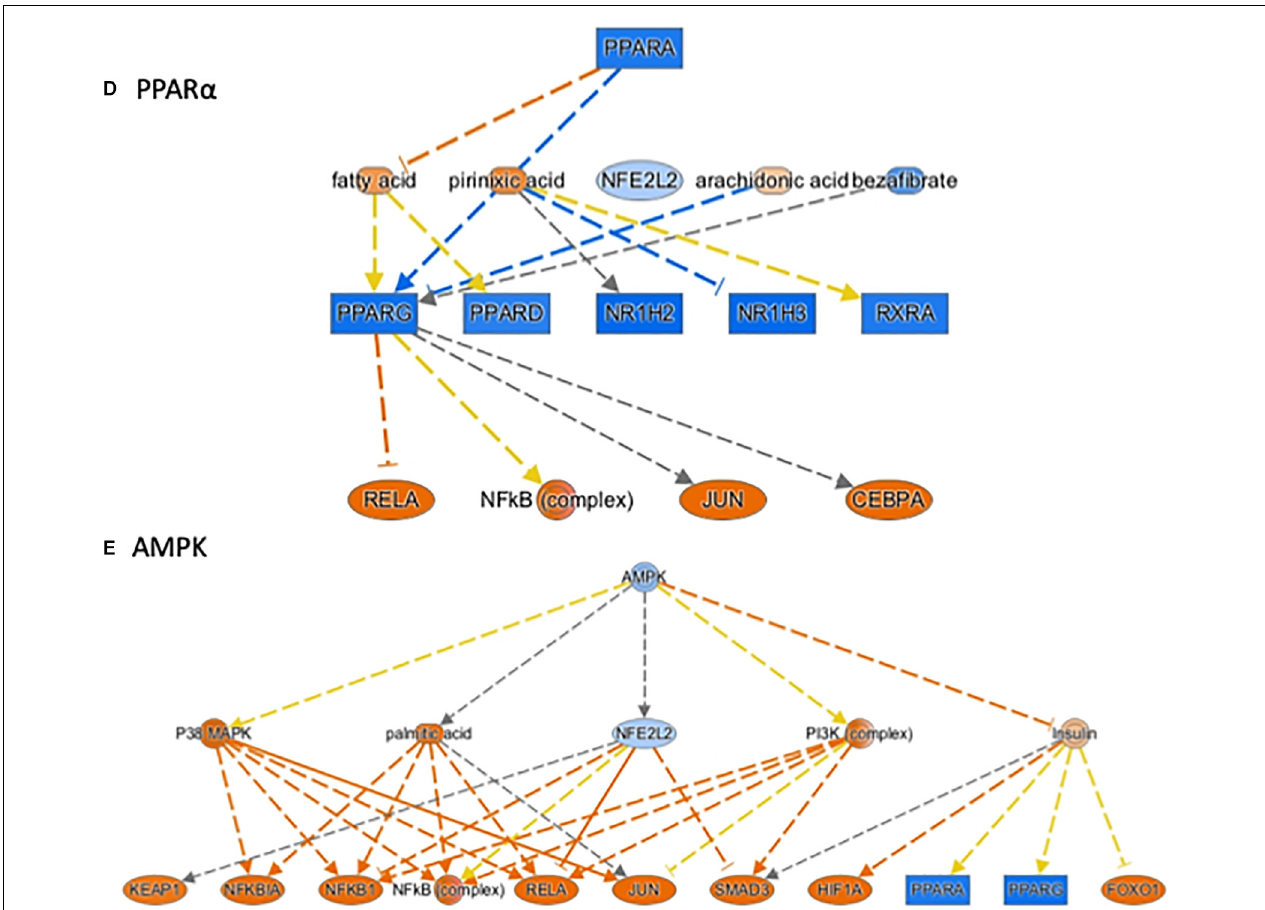
FIGURE 2 | Ingenuity Pathway Analysis R (cid:13) (IPA) annotated mechanistic networks regulated by critical upstream regulators. Differentially expressed genes regulated by FOXO1 (A) , mTOR (B) , HIF1A (C) , PPAR α (D) , and AMPK (E) . Orange-filled and blue-filled shapes indicate predicted activation and inhibition, respectively, red-filled and green-filled shapes indicate increased and decreased expression, respectively, orange-red lines indicate activation; blue lines indicate inhibition; yellow lines indicate findings inconsistent with state of downstream activity; gray lines indicate that the effect was not predicted.